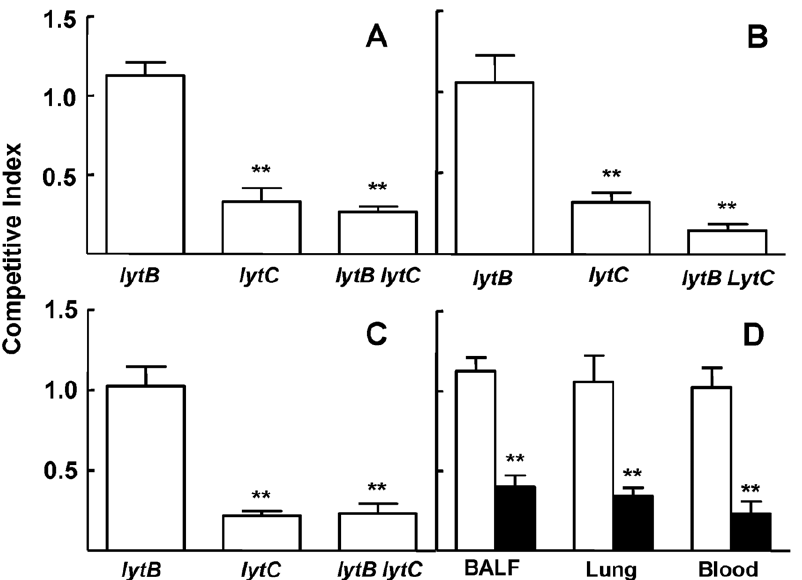
Figure 7. Impact of mutations in the genes encoding LytB and LytC on pneumococcal pneumonia. (A to C) CIs of lytB , lytC and the double lytB lytC strains compared to their parental D39 wild-type strain in BALF (A), lungs (B), and blood (C) after intranasal inoculation of a mixed culture of the corresponding mutant with the wild-type strain. Error bars represent SDs of the mean and asterisks indicate results that are statistically significant compared to those for the lytB strain which was outcompeted (two-tailed Student’s t test; *, P , 0.05; **, P , 0.01; ***, P , 0.001). (D) CIs of lytB vs. D39 (open bars) and lytB lytC vs. lytC (blackened bars) in BALF, lungs, and blood after intranasal infection. **, P , 0.01 for the comparison of both CIs at the corresponding sites of infection (two-tailed Student’s t test).